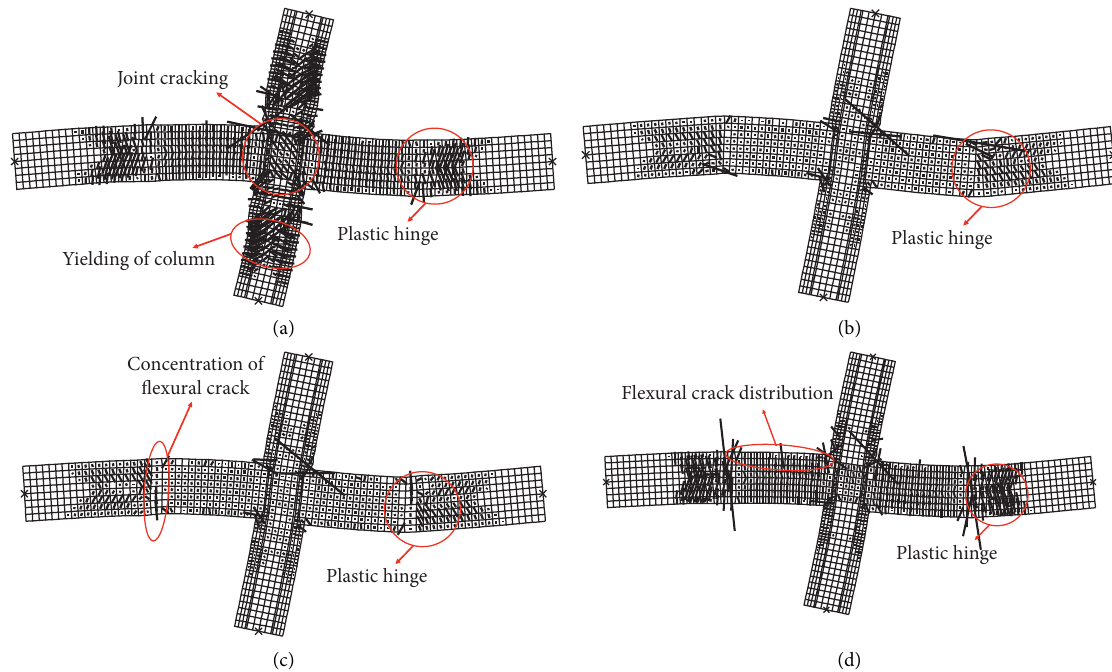
Figure 16: Crack pattern according to moment strength ratio (specimen PC-I50-0.2). (a) Moment strength ratio of 1.0. (b) Moment strength ratio of 1.2. (c) Moment strength ratio of 1.4. (d) Moment strength ratio of 1.6.